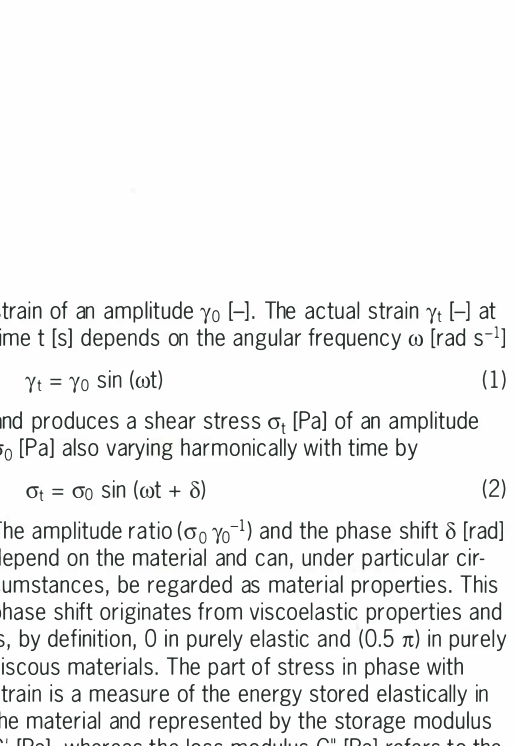
Fig. 1: Flow scheme